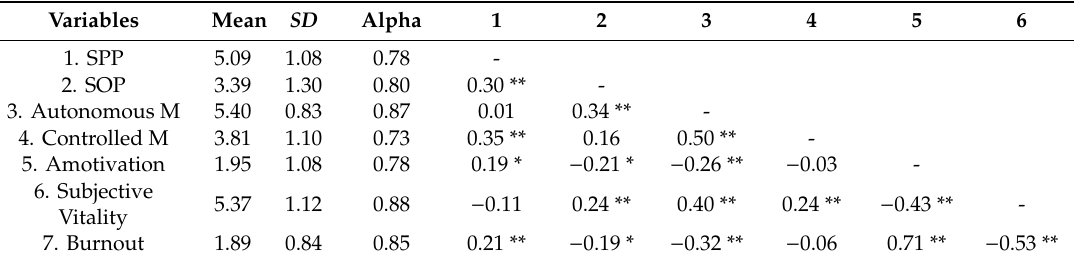
Table 1. Descriptive statistics, reliabilities, and bivariate correlations for study